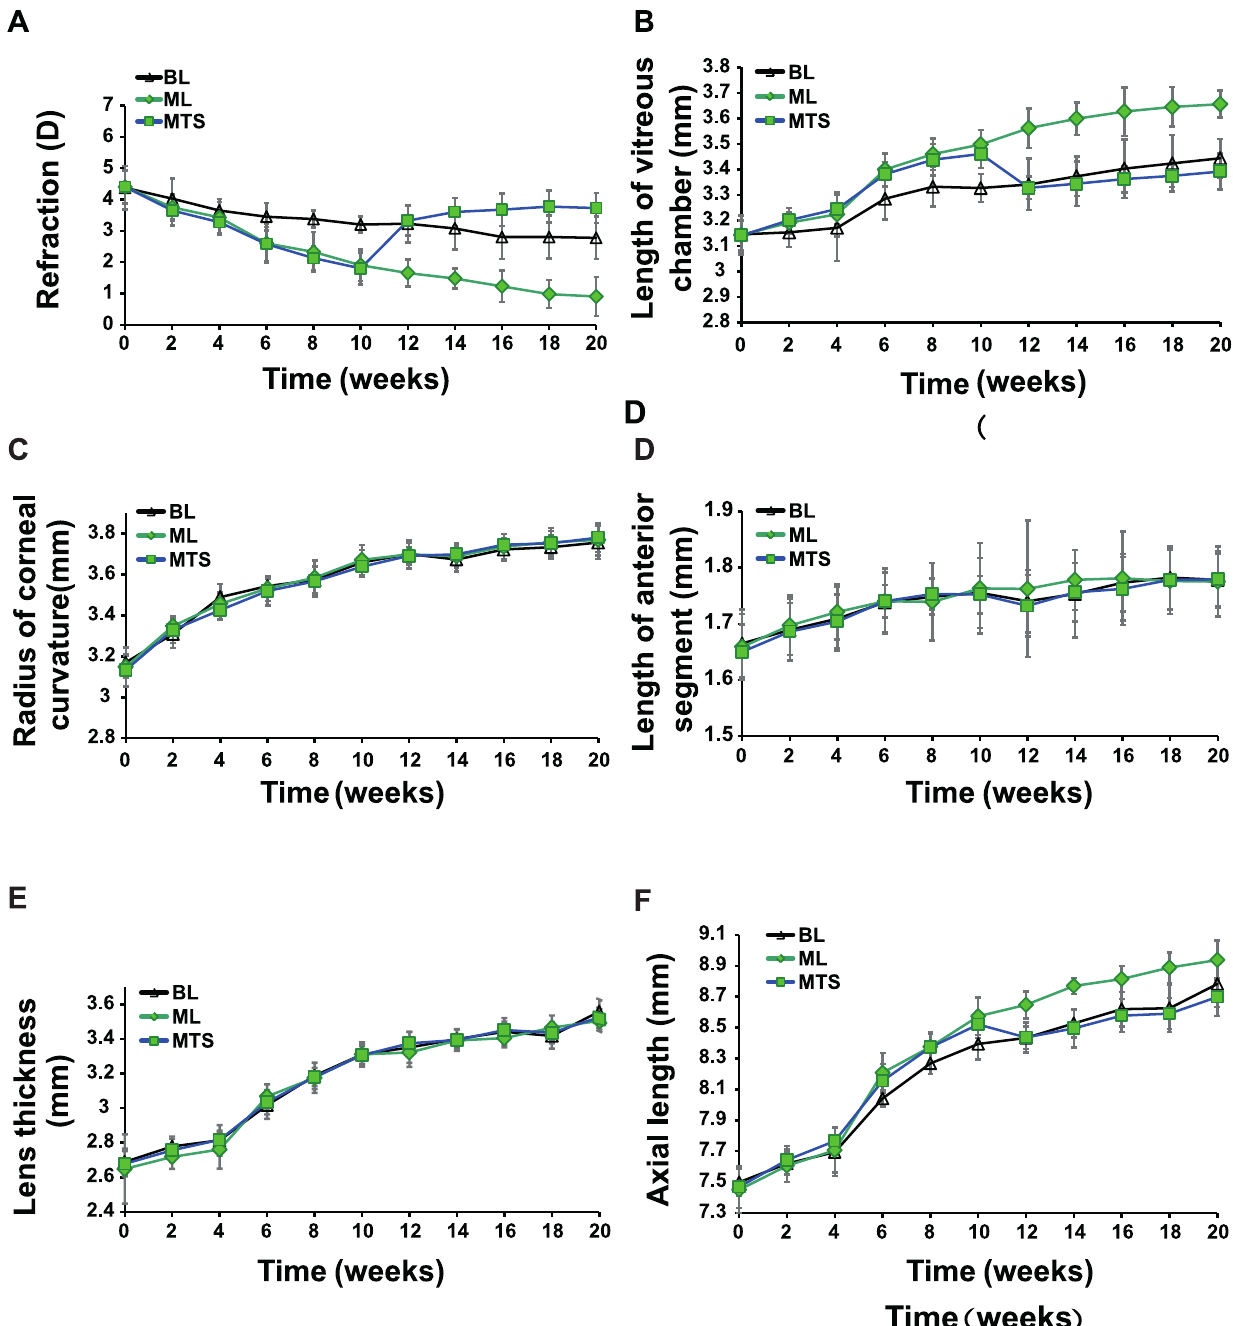
Figure 1. The comparisons in refraction and axial components between the MTS and the control groups. (A) refraction; (B) vitreous length.; (C) corneal curvature; (D) length of anterior segment; (E) lens thickness; (F) axial length; middle-wavelength to short-wavelength group (MTS); middle-wavelength light group (ML); broad-band light group (BL).